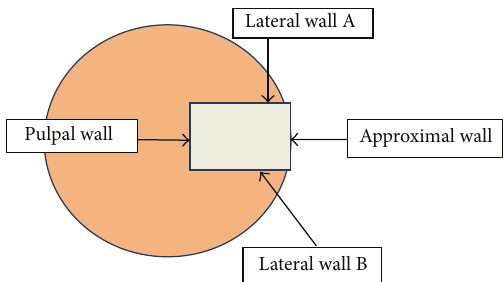
Figure 1: Graphic model of microleakage assessment on the trans- verse cross section.